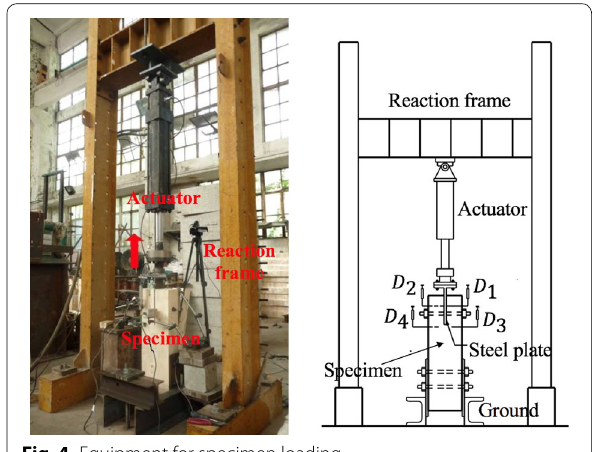
Fig. 4 Equipment for specimen loading